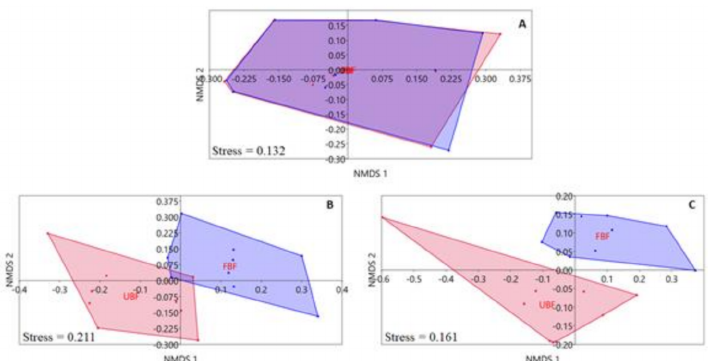
Figure 2. The unconstrained (nMDS) ordination of sites based on values of environmental variables from the catchment ( A ) and the local scales: riparian habitat characteristics ( B ), riparian integrity condition scores ( C ). Unbuffered sites (UBF) = red, forested buffered sites (FBF) =